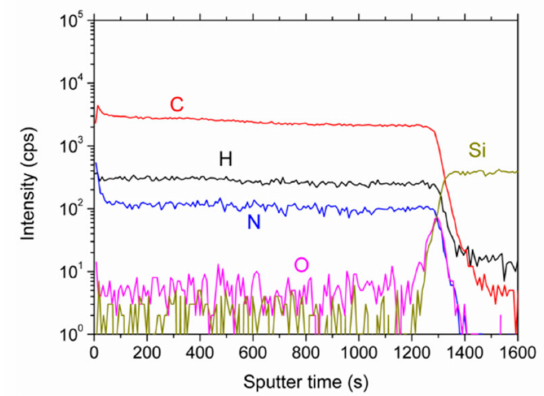
Figure 4. Secondary ion mass spectrometry (SIMS) depth profile of the N-DLC film prepared with pure aniline. The displayed intensities are the ones of the CsX +